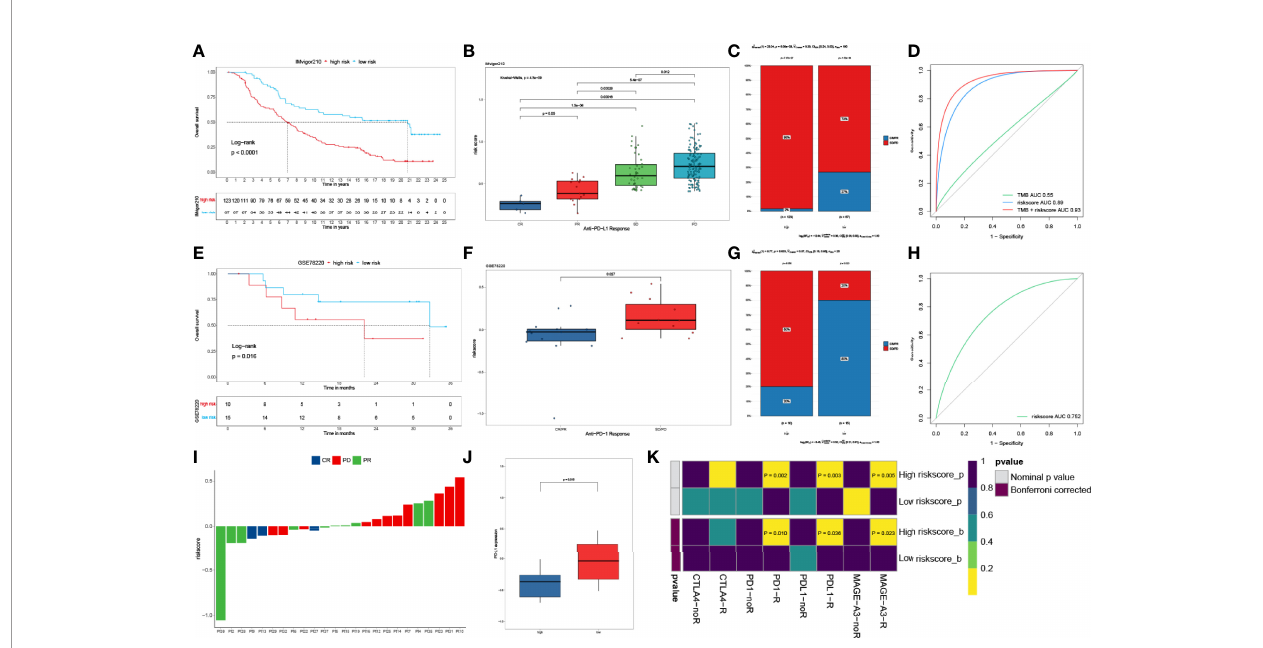
FIGURE 6 | IPM predicts immunotherapeutic bene fi t. (A) KM curves for patients with low- and high-risk scores in the IMvigor210 cohort. (B) Risk score distribution with different anti-PDL1 clinical responses in the IMvigor210 cohort. (C) Relative proportion of clinical response to anti-PDL1 immunotherapy in low- and high-risk groups in the IMvigor210 cohort (PD, progressive disease; SD, stable disease; PR, partial response; CR, complete response). (D) ROC curves of TMB, risk score and combination of TMB and risk score in IMvifor210 cohort. (E) KM curves for patients in low- and high-risk groups in the GSE78220 cohort. (F) Distribution of risk scores with different anti-PDL1 clinical responses in the GSE78220 cohort. (G) Relative proportion of clinical response to anti-PDL1 immunotherapy in low and high risk groups in the GSE78220 cohort. (H) ROC curves of risk score in the GSE78220 cohort. (I) The IPM risk score of each patient. (J) Gene expression levels of PR- partial response between low- and high-risk groups. (K) Putative immune therapy response of low- and high-risk